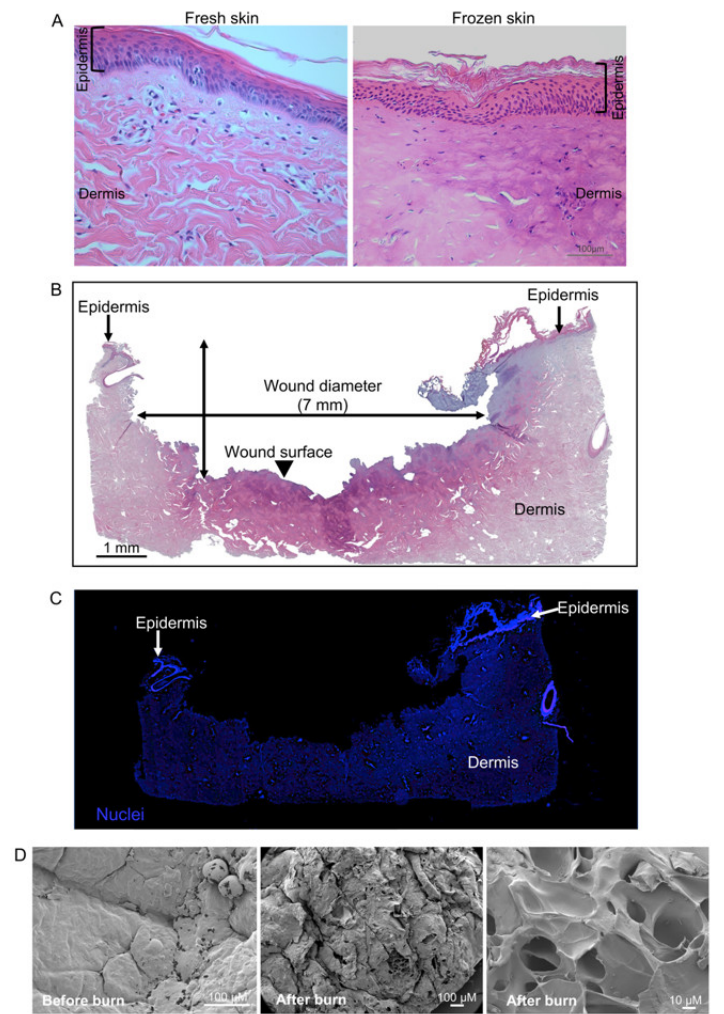
Figure 3. Histology and characteristics of burn-induced ex vivo wounds. ( A ) H&E stained sections showing histology comparing freshly excised and freeze-thawed porcine skin tissue. ( B ) Repre- sentative images showing panoramic composition of ex vivo wound tissue. Stitched image of H&E-stained wound tissue sections (containing images taken with a 5× objective) from